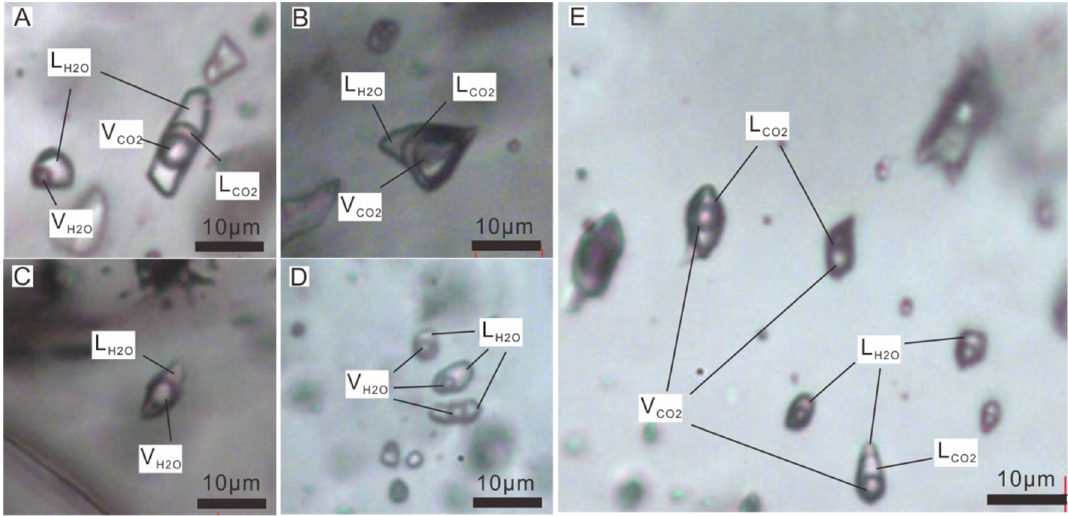
Figure 5. Photomicrographs of typical fluid inclusions in quartz from the Baiyinhan tungsten deposit. ( A ) Liquid-rich C-type inclusion. ( B ) Vapor-rich C-type inclusion. ( C ) V-type inclusions. ( D ) Clustered L-type inclusions. ( E ) Clustered C-type inclusions. Abbreviation: L CO2 = liquid CO 2 ; L H2O = liquid H 2 O; V CO2 = vapor CO 2 ; V H2O = vapor H 2